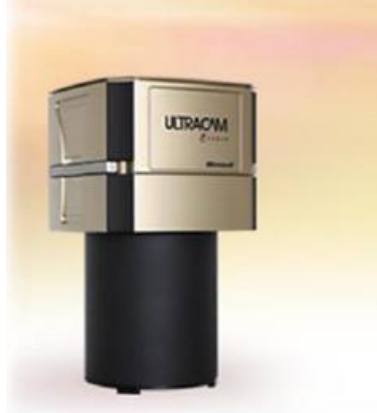
Figure 4. View of ULTRA CAM